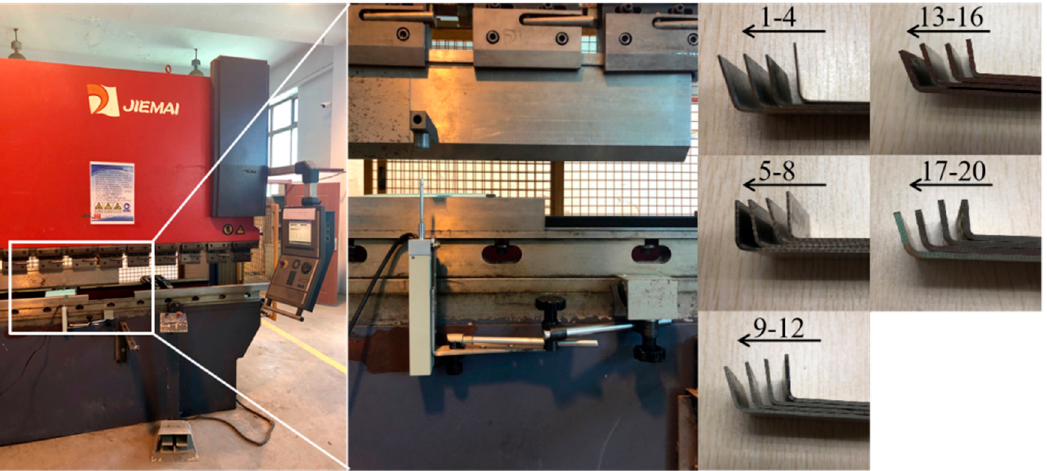
Figure 3. Bending machine and bending parts.